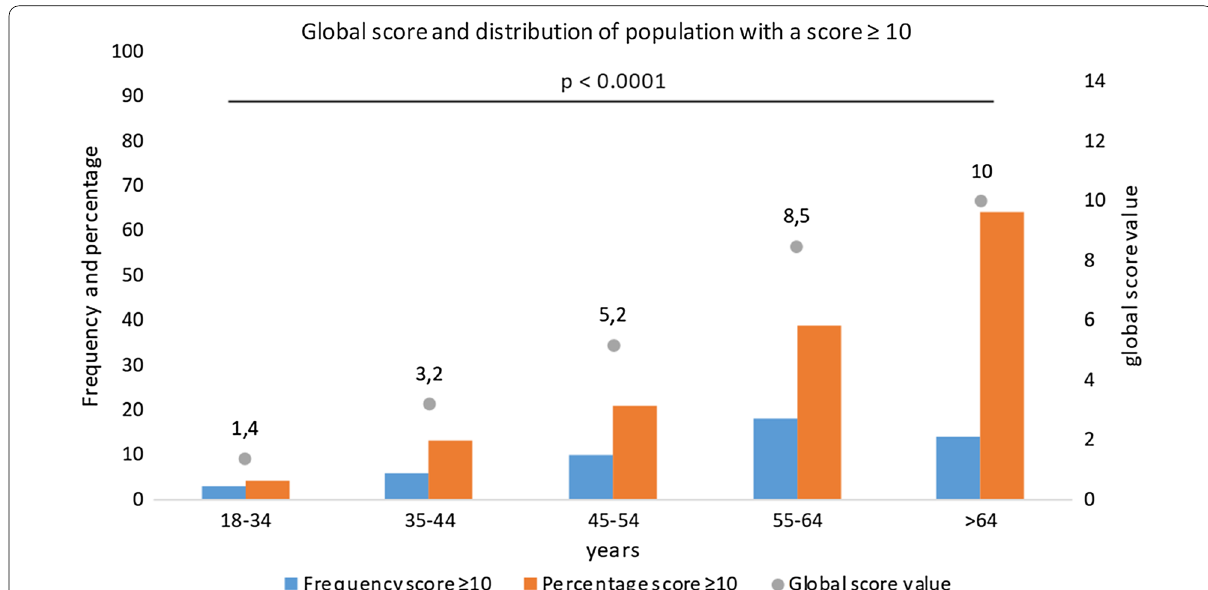
Fig. 3 Global score and distribution of population with a score score 10 and the global score is higher when patients are older. There was a significant difference between all groups ≥